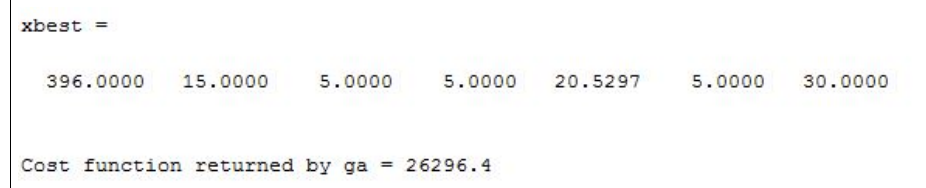
Figure 8. Optimal Sizing of System Components for diesel generator.